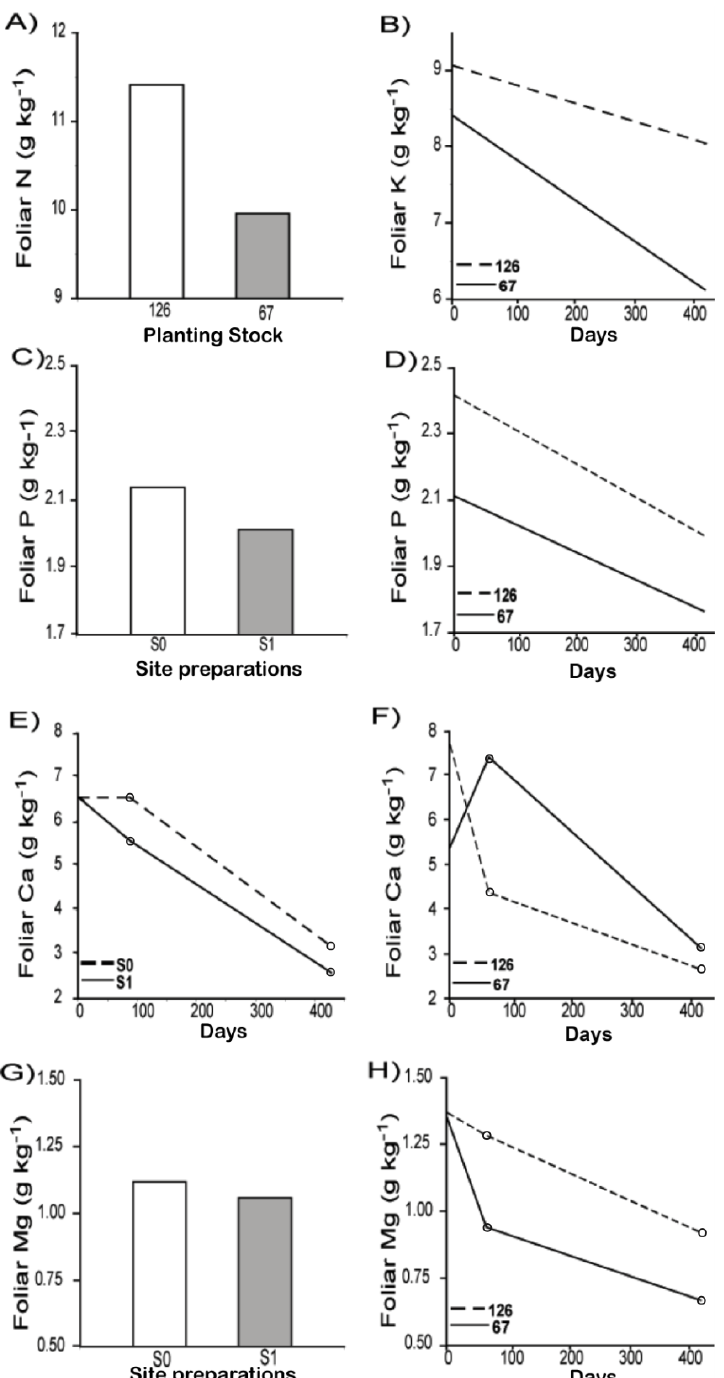
Figure 4. Stand type (ST), date (D), site preparation (S) and planting stock size (PS) effects on ( A ) foliar N, ( B ) foliar K (linear D * PS interaction), ( C and D (linear D * PS interaction)) Foliar P, ( E (quadratic D * S interaction)) and ( F (quadratic D *